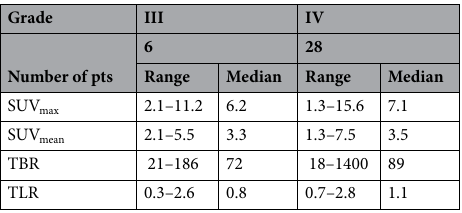
Table 2. Analyzed parameters: SUV max , SUV mean , TBR and TLR in the subgroups—per-patient analysis.